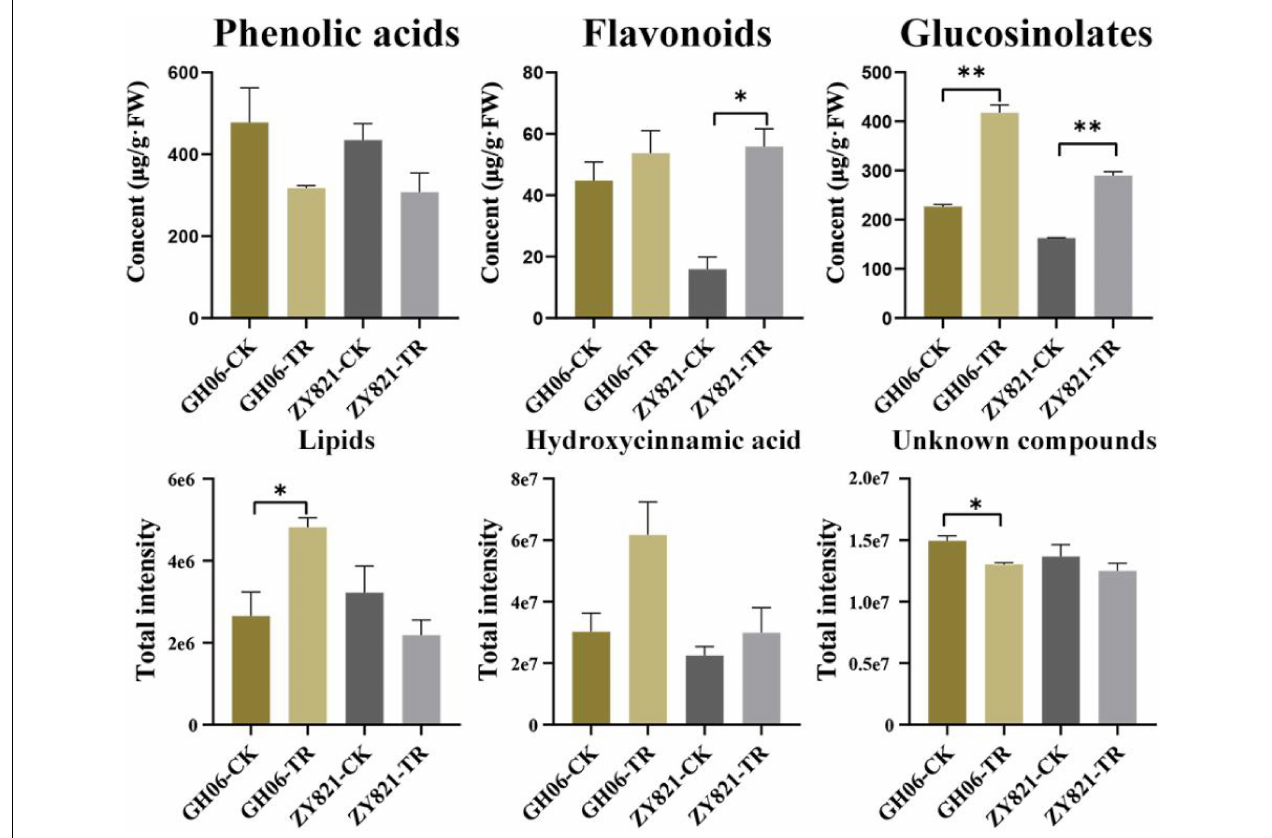
FIGURE 2 | The total contents of detected compounds in rapeseed siliques under the control and shading treatment at 35DAP. Error bars represent the means ± SD, and the asterisks represent significant differences from the control, with ∗ P < 0.05 or ∗∗ P < 0.01. CK, the control; TR, shading